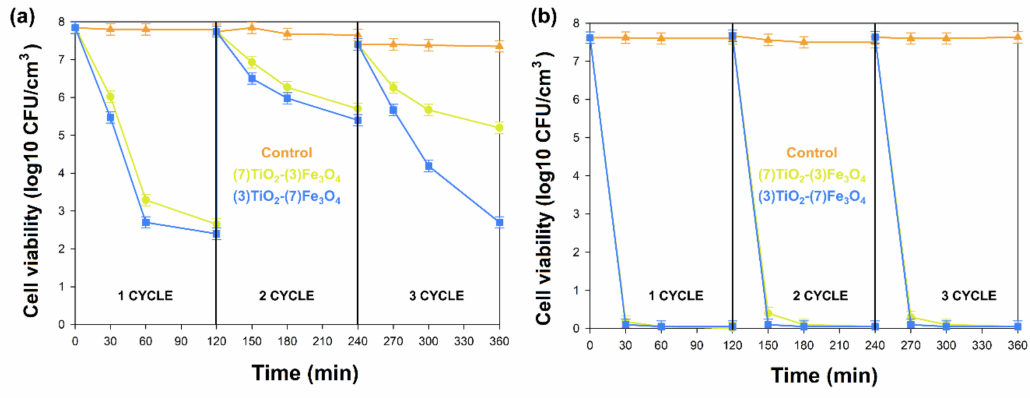
Figure 11. Antibacterial activity of examined materials during three cycles against Staphylococcus aureus ( a ) and Escherichia coli ( b